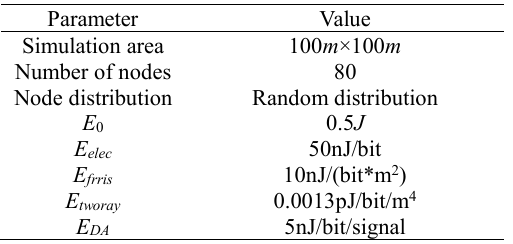
Table 1. Simulation Parameter